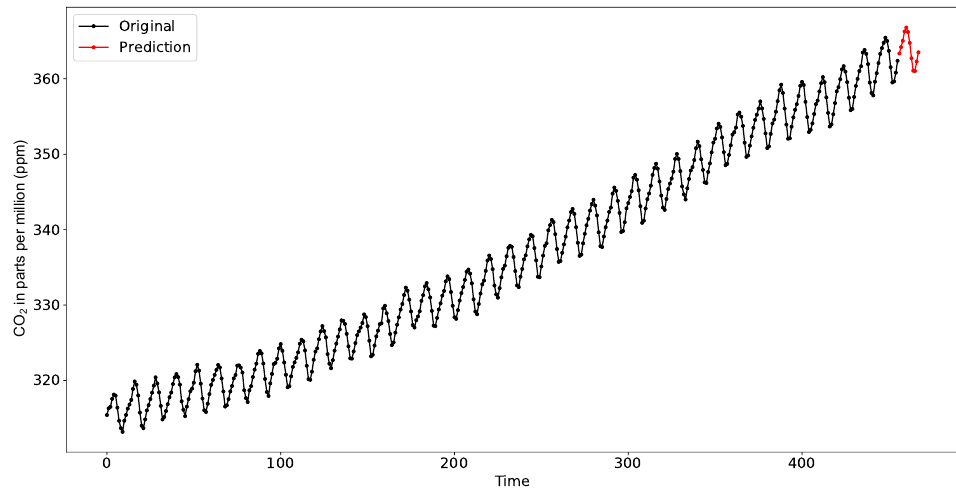
Figure 5. Result of dpsf_plot() for the “CO 2 ”